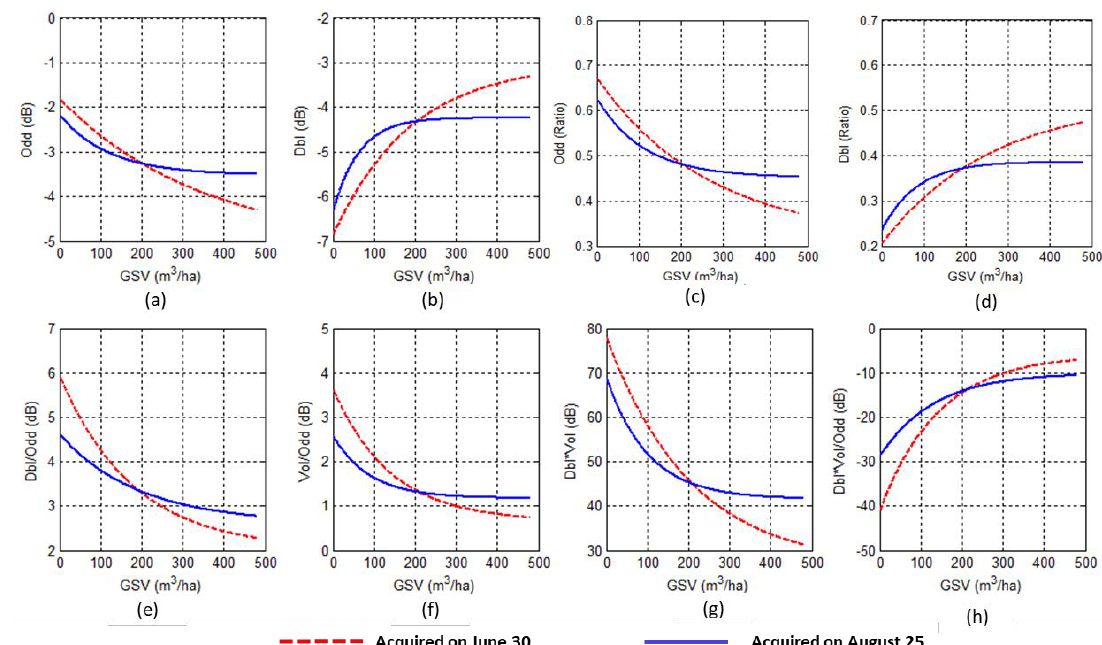
Figure 5. Relationships between the forest GSV and polarimetric characteristics of the image acquired on 30 June 2016 by the semi-exponential model; ( a – d ) are the results using the logarithm or ratio transformations of scatterings; ( e – h ) are the results using the fused polarimetric characteristics.